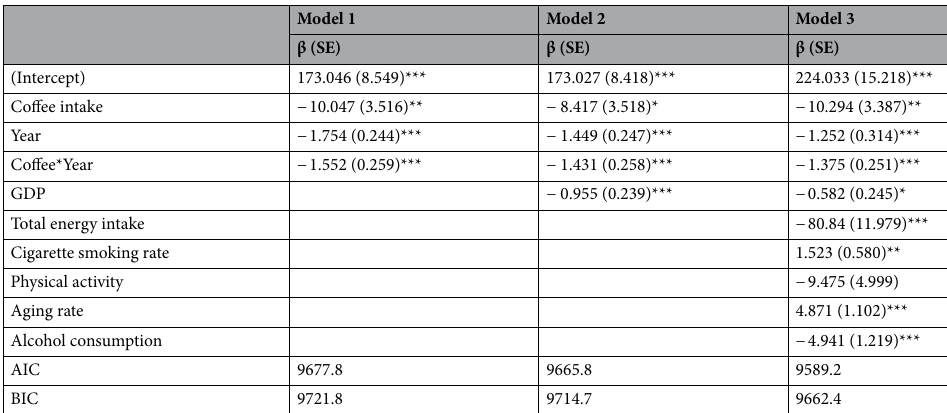
Table 2. Fixed effects of coffee intake, year, coffee intake–year interaction, and covariates on the IHD mortality rate per 100,000 population in the three linear mixed-effects models. Model 1: No covariates were adjusted. Model 2: GDP (US$1000/capita) was adjusted. Model 3: GDP, total energy intake (1000 kcal/day/ capita), cigarette smoking rate (%), physical activity (1000 metabolic equivalents-min/week), aging rate (%), and alcohol consumption (grams of ethanol/day/capita) were adjusted. GDP gross domestic product, BMI body mass index, AIC Akaike’s information criterion, BIC Bayesian information criterion, SE standard